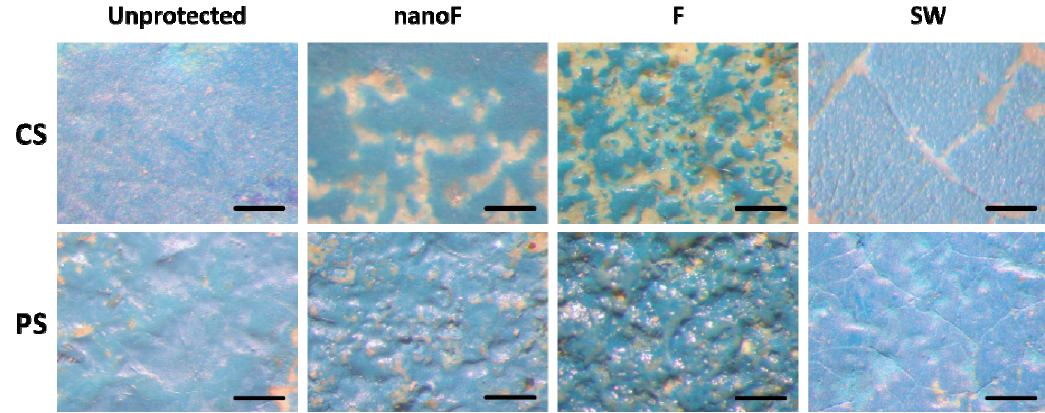
Figure 7. Images taken by the stereomicroscope of the surfaces stained by spray paint: comparison between the protected and unprotected surfaces (CS = compact stone; PS = porous stone). Each scale bar indicates 200 µm.